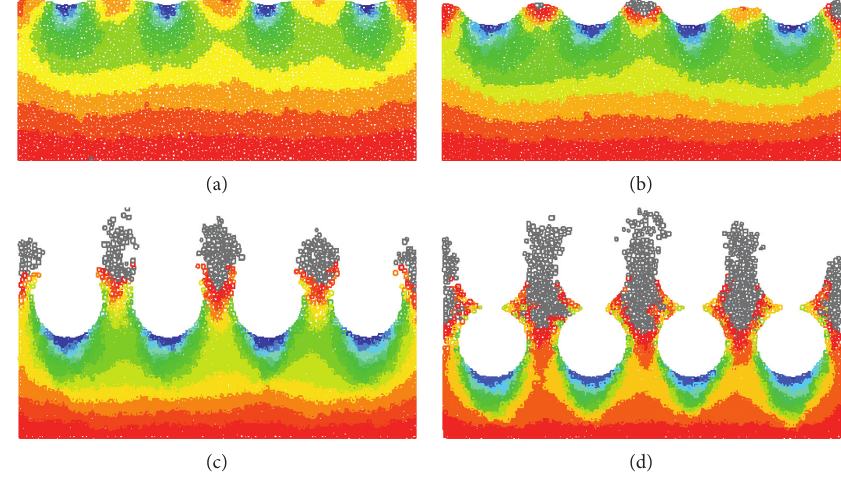
Figure 6: Vertical displacement of particles at different time steps. (a) Cloud chart of particle displacement at 2500 time steps. (b) Cloud chart of particle displacement at 5000 time steps. (c) Cloud chart of particle displacement at 10,000 time steps. (d) Cloud chart of particle displacement at 15,000 time steps.